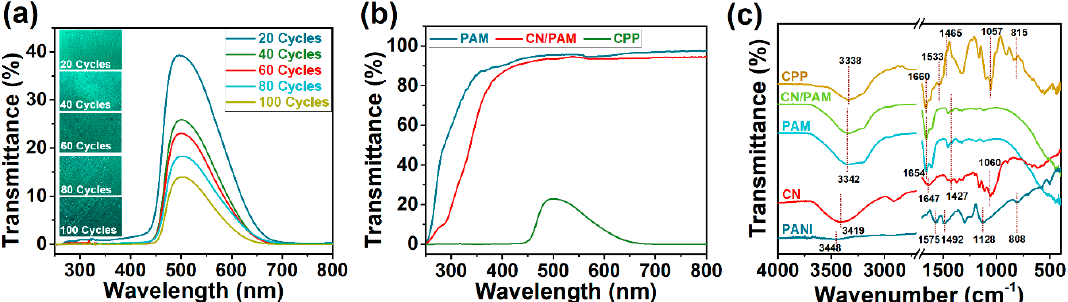
Figure 3. The optical and structural characterizations of the products. ( a ) UV–vis spectra of CPP composite hydrogels prepared with different electrodeposition cycles (inset: digital photographs of CPP samples with different cycles); ( b ) UV–vis spectra of PAM, CN/PAM, and CPP composite hydrogel (60 cycles); ( c ) FTIR spectra of CN, polyaniline (PANI), PAM, CN/PAM, and CPP composite hydrogel.